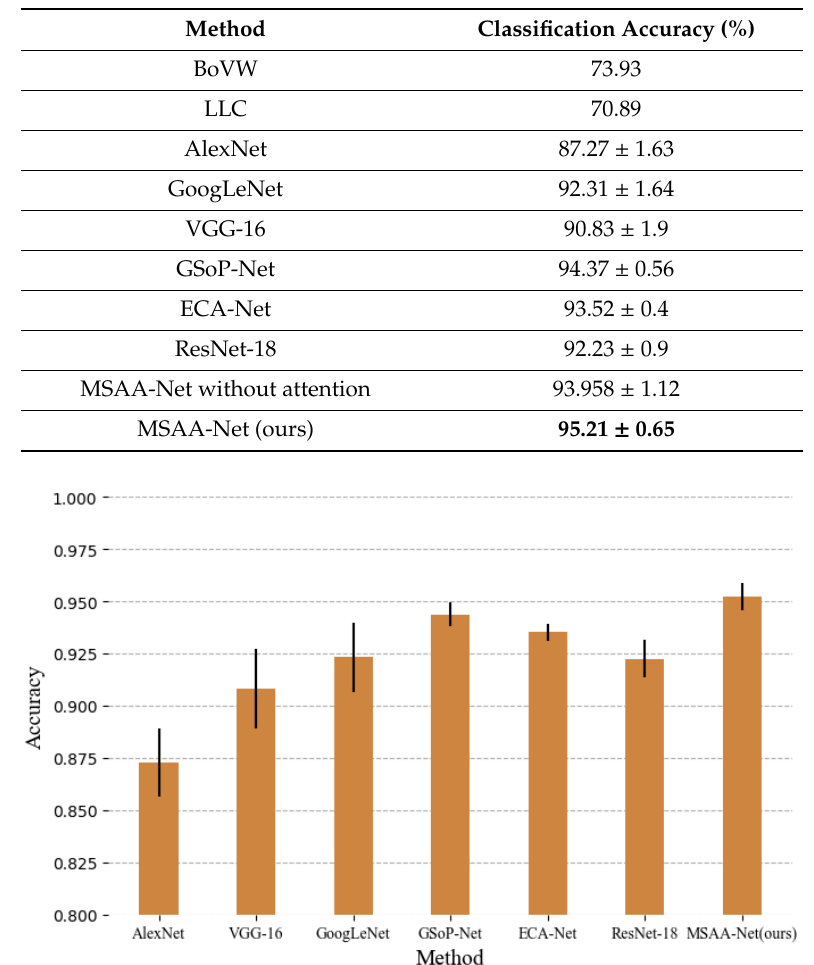
Figure 15. Classification results of different methods for the Google dataset of SIRI-WHU.